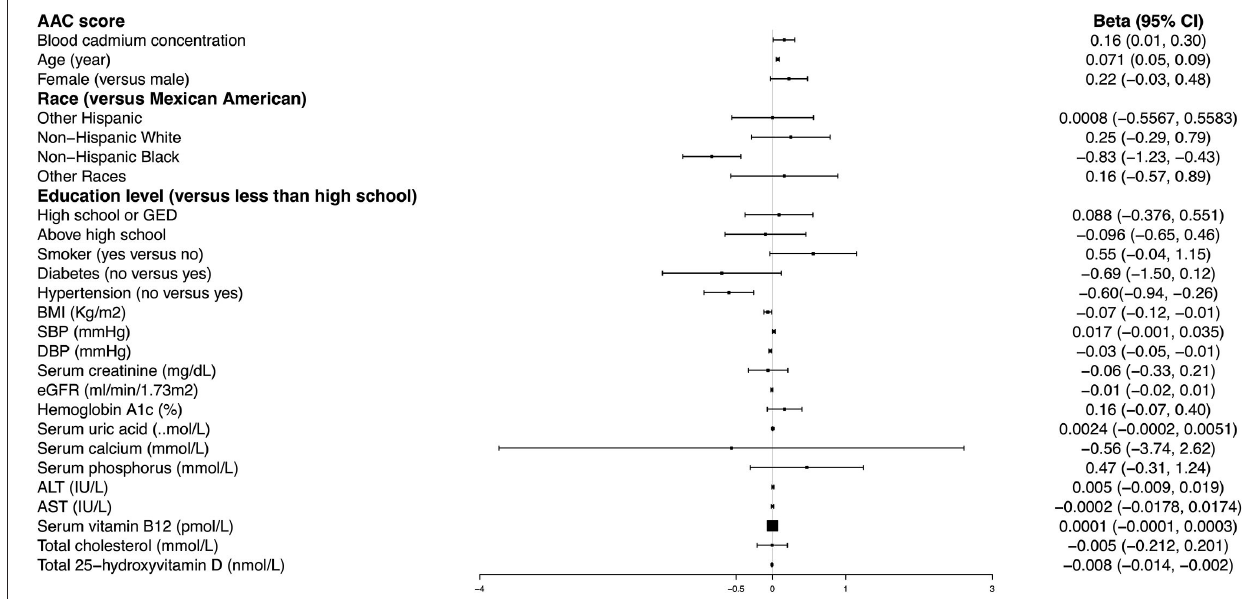
FIGURE 2 | Multivariate logistic regression models of abdominal aortic calcification (AAC) score.